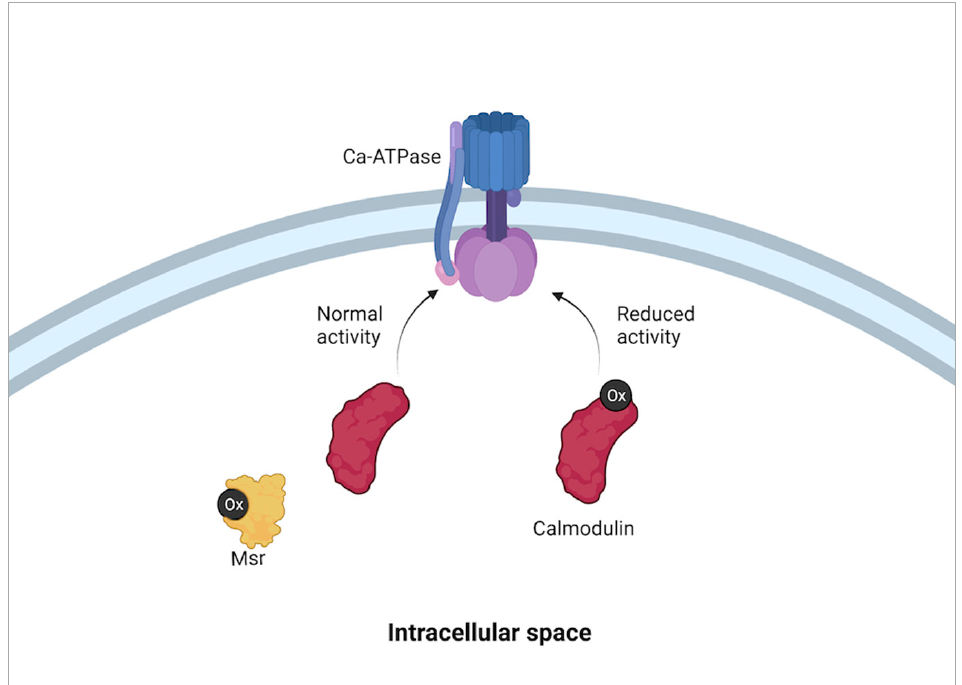
Figure 5. Modulation of calmodulin activity with oxidative state. When reactive oxidative species (Ox in black) concentration is high in a cell, the oxidation of methionine residues within calmodulin modifies its activity. This in turn reduces the activity of Ca-ATPase pumps embedded within the plasma membrane. The reduction of Ca-ATPase pump activity alters intracellular Ca balance which then causes a reduction on cell metabolism. The reduction of methionine residues on calmodulin by methionine sulfoxide reductases (Msr) then returns normal activity to calmodulin and therefore cell Ca-ATPase pumps and cell metabolism [53].